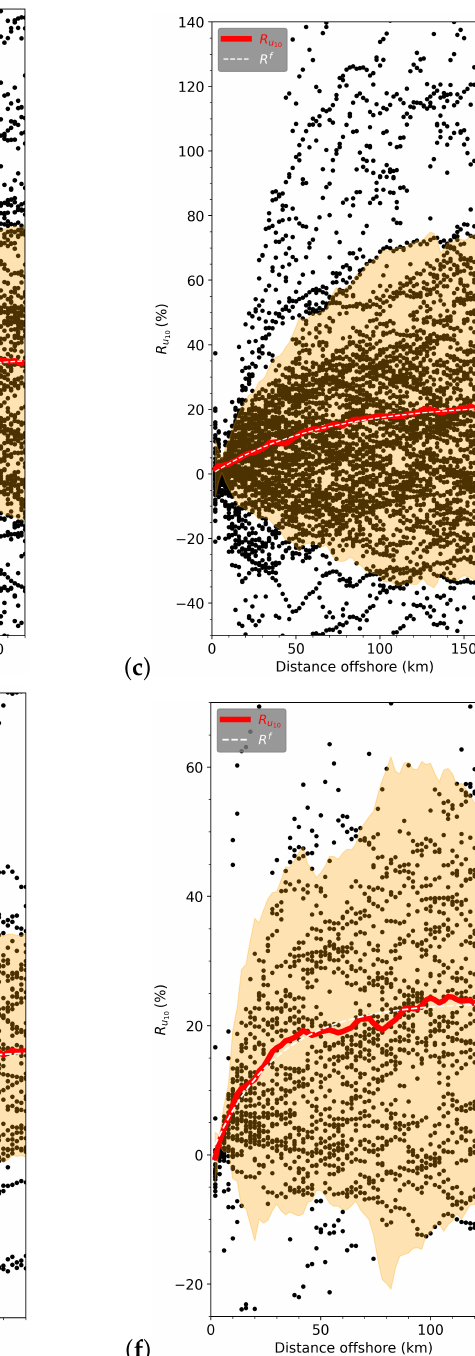
Figure 9. ( a – c ) 10 m wind speed derived from Sentinel 1A/B (dots) for easterly winds for 2017–2020 along the transect “Ref” in Figure 2b ( a ). The corresponding parameters δ u 10 , R u in ( b , c ), respectively. ( d – f ): The same as ( a – c ) but for southerly winds for 2017–2020 along the transect “Ref” ( d ) and corresponding δ u 10 ( e ) and R u curves represent, respectively, the mean value, the standard deviation and the empirical model fits (Equations (10), (14) and